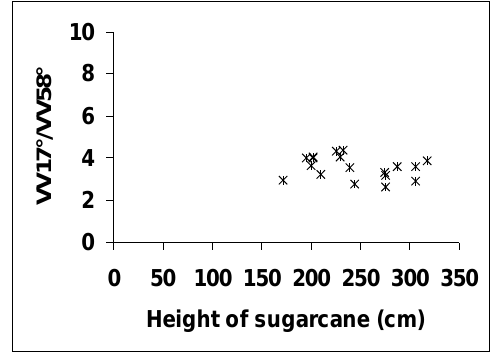
Figure 6. Ratio of TerraSAR-X signals HH17°/HH58° and VV17°/VV58°. The sugarcane height corresponds to the height of terminal visible dewlap